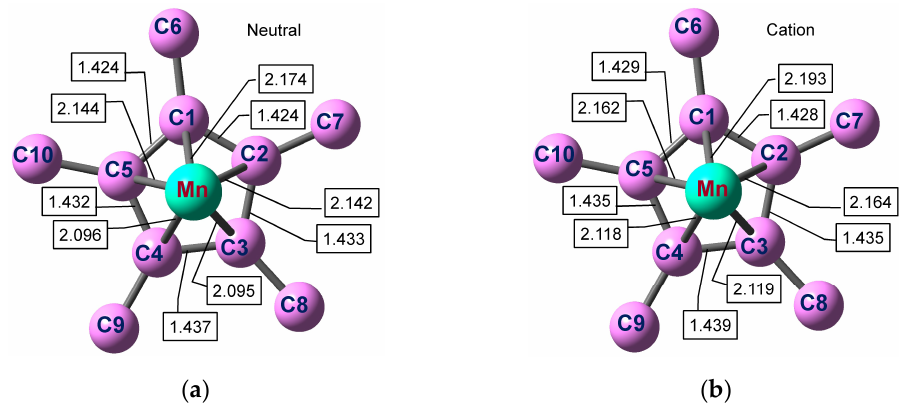
Figure 5. Mn-C(ring) and C(ring)-C(ring) distances (Å) in the optimized Cp* 2 Mn 0 neutral ( a ) and Cp* 2 Mn + cation ( b ). The hydrogen atoms are omitted for clarity.